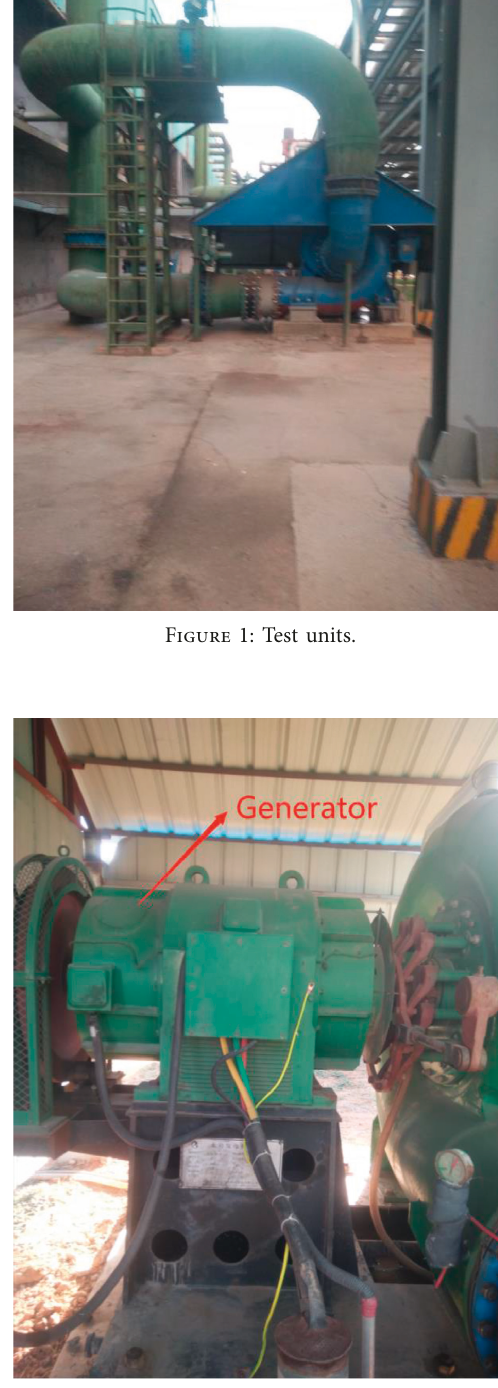
Figure 2: Measuring point layout of the generator.